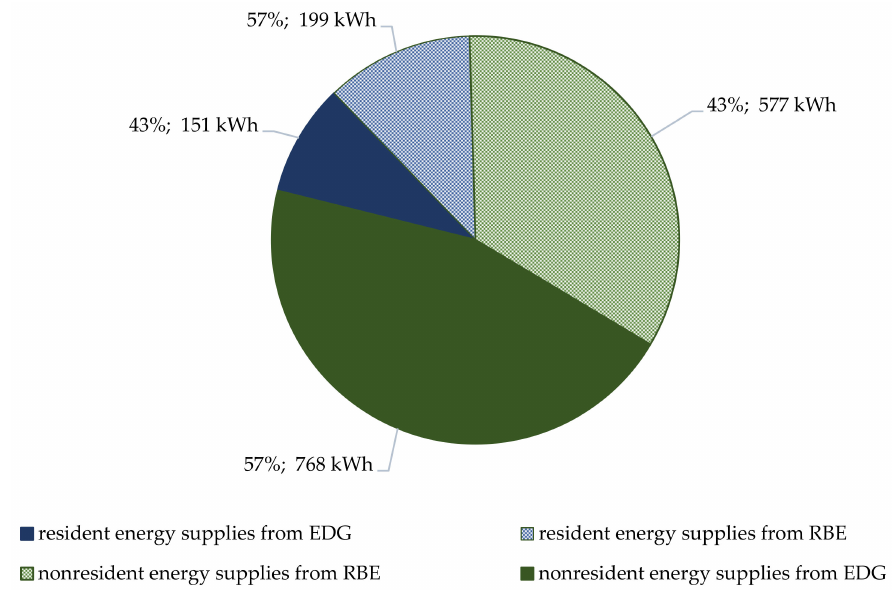
Figure 9. Proportion of RBE and EDG in car park electricity consumption during weekday